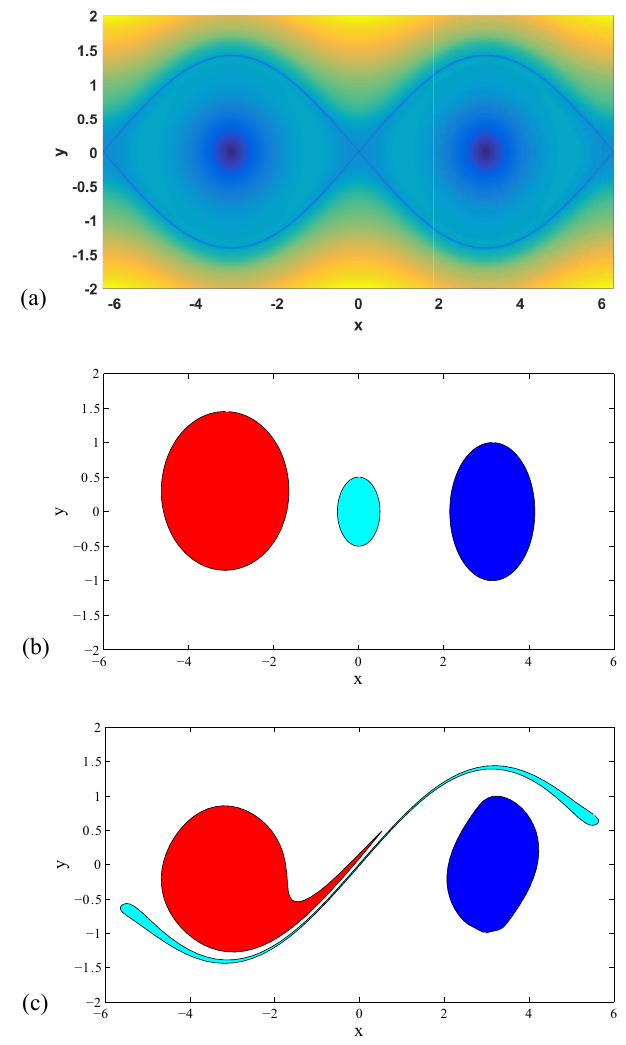
Figure 5. (a) Lagrangian skeleton for the stationary cat eyes; (b) three initial patches of a purely advective field; (c) evolution of the patches at time t = 5 . 6.